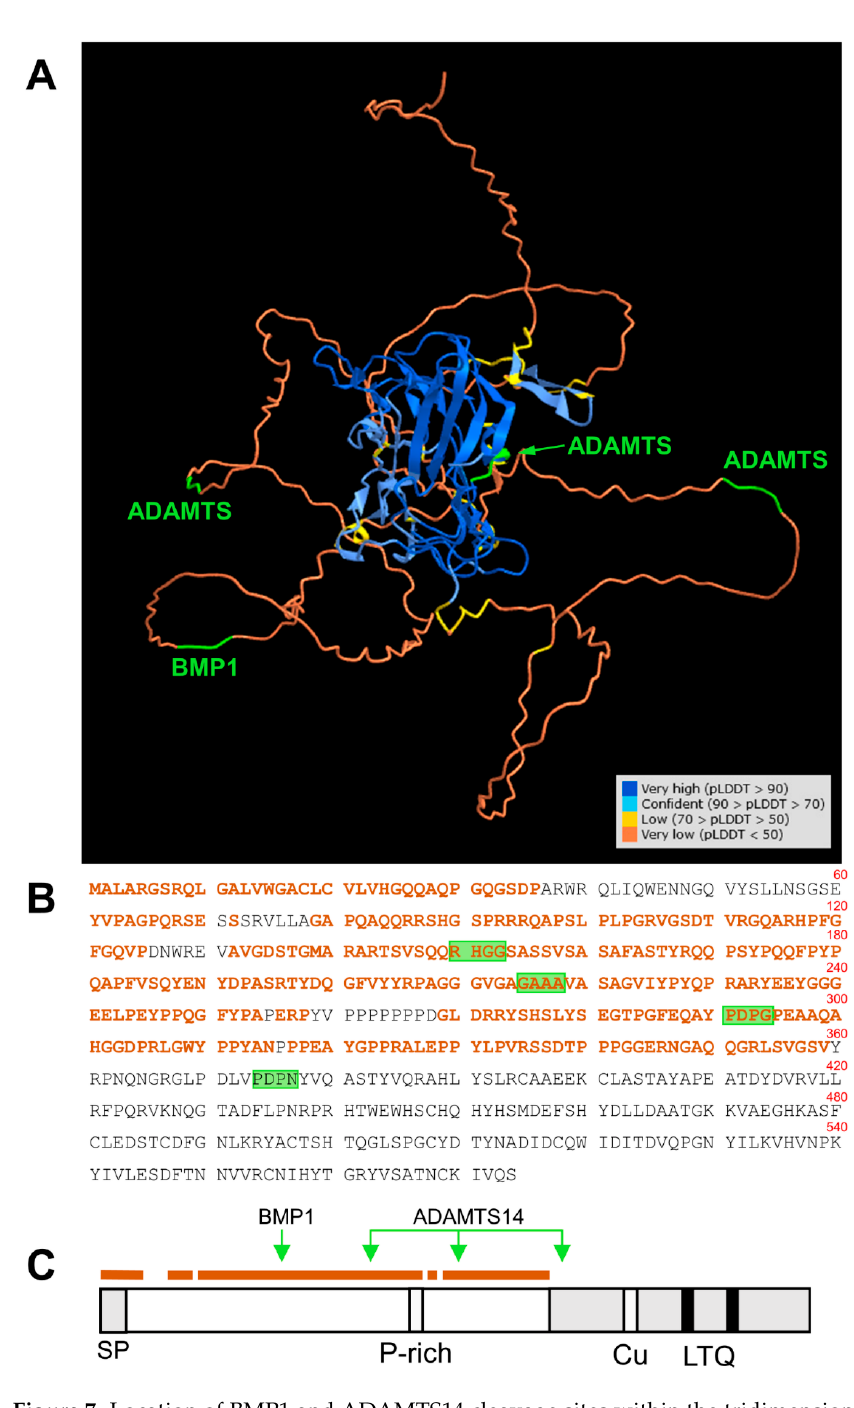
Figure 7. Location of BMP1 and ADAMTS14 cleavage sites within the tridimensional structure of LOXL1 protein as predicted by AlphaFold. ( A ) AlphaFold prediction model for LOXL1 protein showing the degree of confidence (predicted local distance difference test, pLDDT) with a color code as indicated (https://alphafold.ebi.ac.uk/). The N-terminal region up to position 360 mostly displays an unstructured folding (pLDDT < 50, brown), a predictor of a disordered region. This unstructured segment is highlighted within the LOXL1 protein sequence ( B , C ). The position of the BMP1 and ADAMTS14 cleavage sites is indicated in green. Note that these processing sites are within the disordered region (BMP1 at 151–152, ADAMTS14 at 216–217, and 292–293), or solvent-exposed within the structure C-terminal domain (ADAMTS14 at